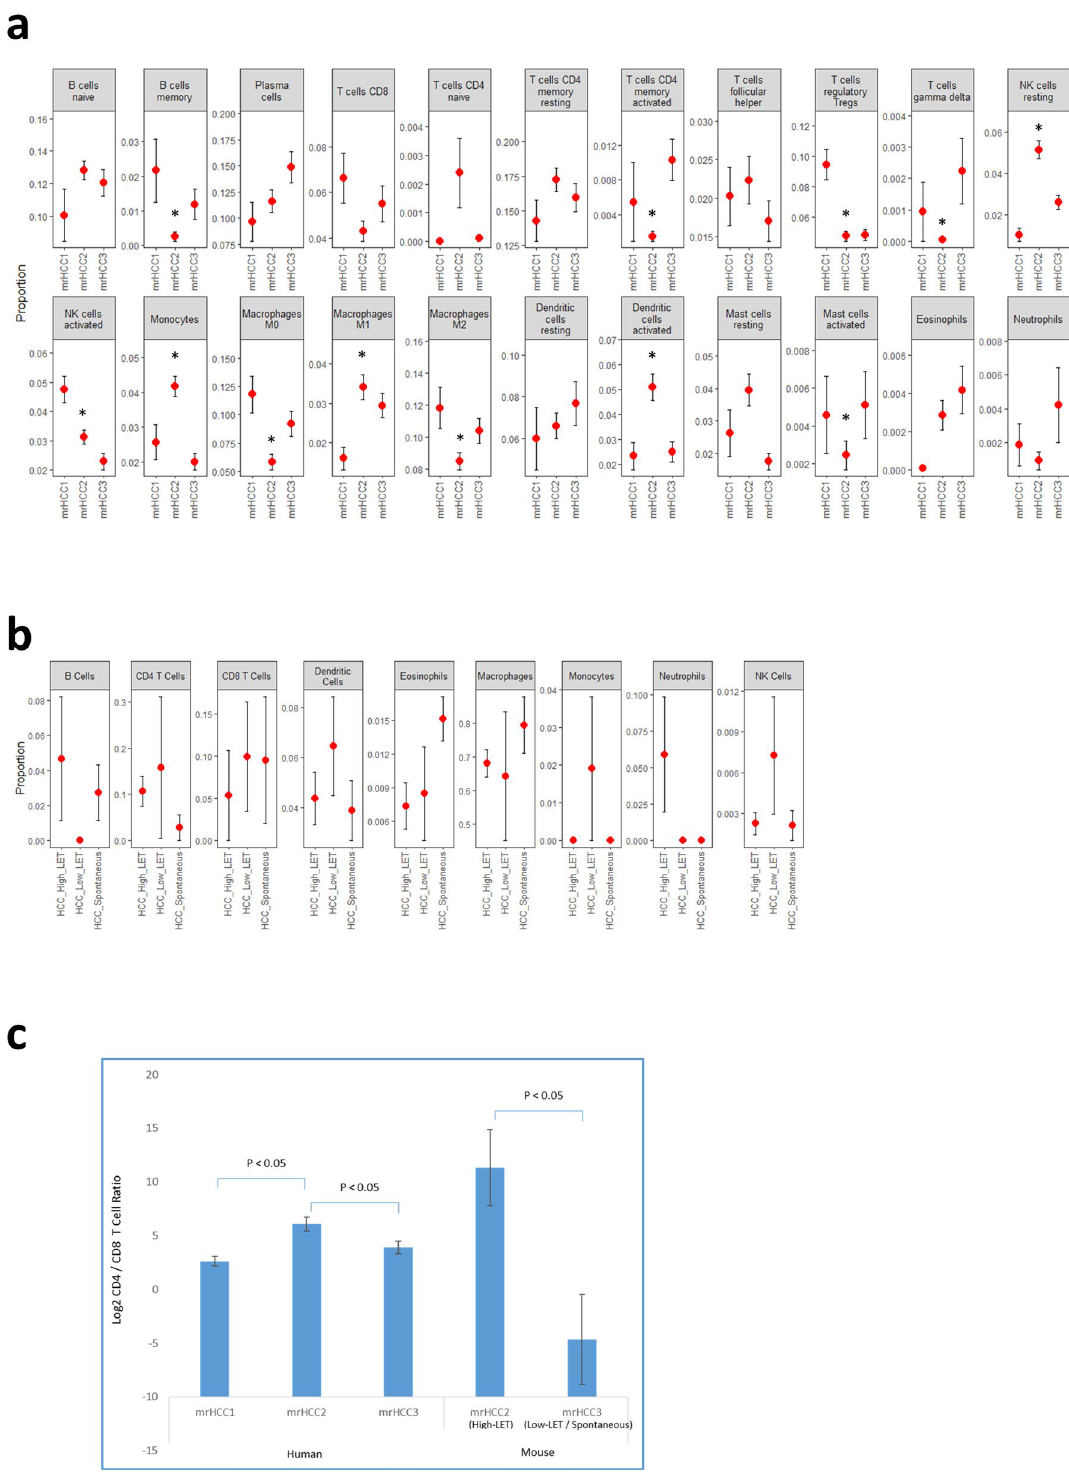
Figure 5. Profiles of tumor-infiltrating immune cells in mouse and human HCC. ( a ) Average values of relative proportions of immune cells in each mrHCC cluster of human TCGA HCC cohorts. Bar: standard error. *Immune cell proportions of mrHCC2 were significantly different from either mrHCC1 or mrHCC3 (p < 0.05). ( b ) Average values of relative proportions of immune cells in high-LET, low-LET and spontaneous mouse HCC. Bar: standard error. ( c ) Ratios of CD4+/CD8+ tumor-infiltrating T cells in different subgroups of mouse and human HCC. Bar: standard